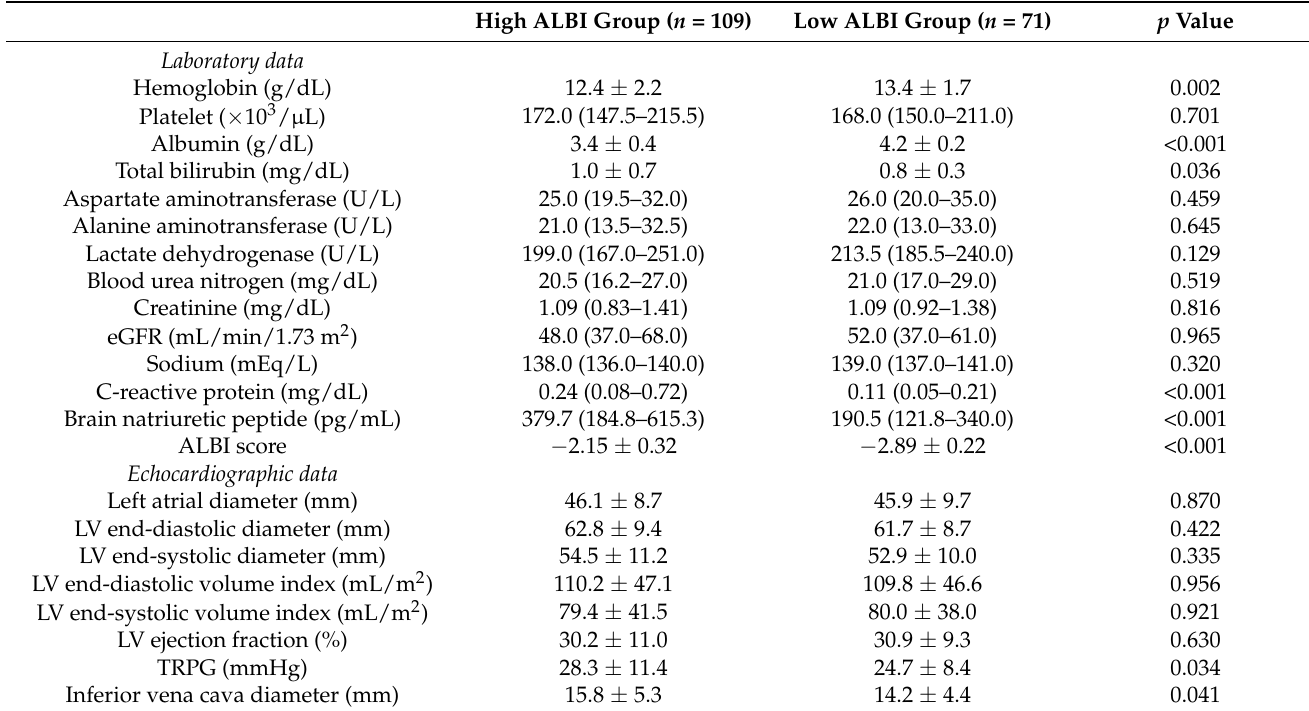
Table 2. Comparison of baseline laboratory and echocardiographic data for the High and Low ALBI